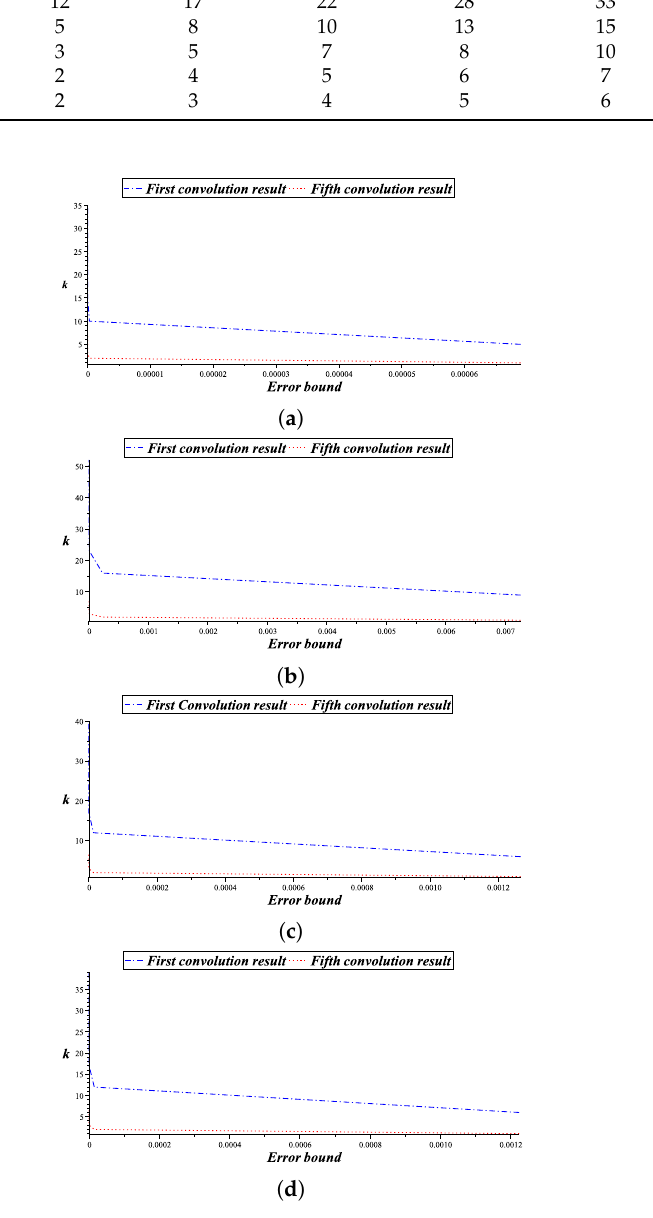
Figure 1. Comparison between first and fifth convolutions. This shows that the error decreases with the increase of convolution. Of course, it decreases with the increase of subdivision depth. ( a ) 2-point scheme [12]; ( b ) 3-point scheme [30]; ( c ) 4-point scheme [8]; ( d ) 4-point scheme